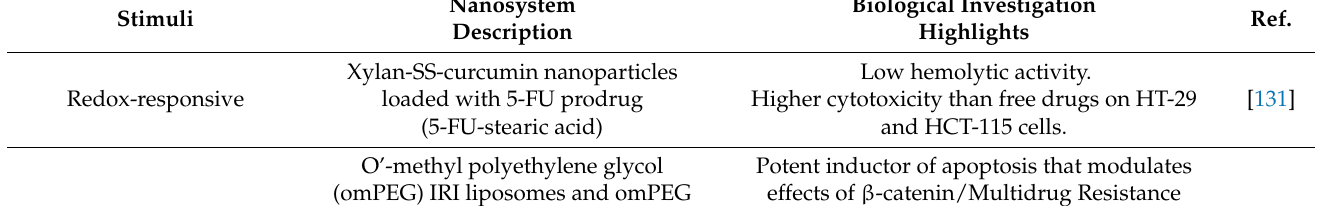
Table 1. Examples of nanosized carriers as stimuli-responsive drug-delivery systems for CRC-targeted therapy.